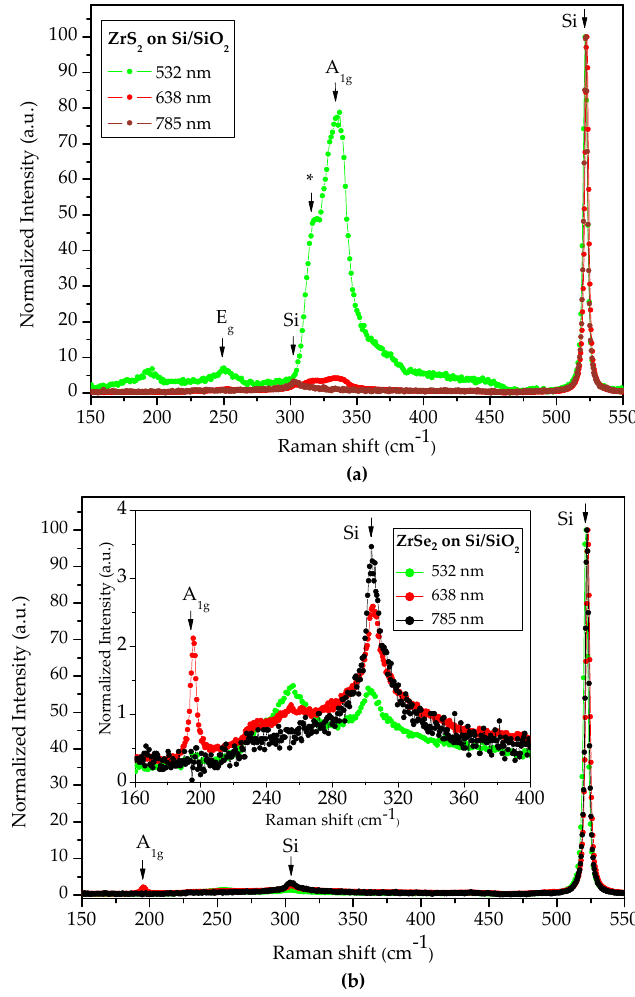
Figure C6. Raman spectra measured at different wavelengths ( λ = 532 nm, 638 nm, and 785 nm) for ( a ) ZrS 2 and ( b ) ZrSe 2 . The intensity has been normalized to the height of the silicon phonon peak. The Raman modes A 1g and E g are labeled. For ZrS 2 , the shoulder marked with “*” is attributed to a broadening of the A 1g peak due to non ‐ harmonic effects.